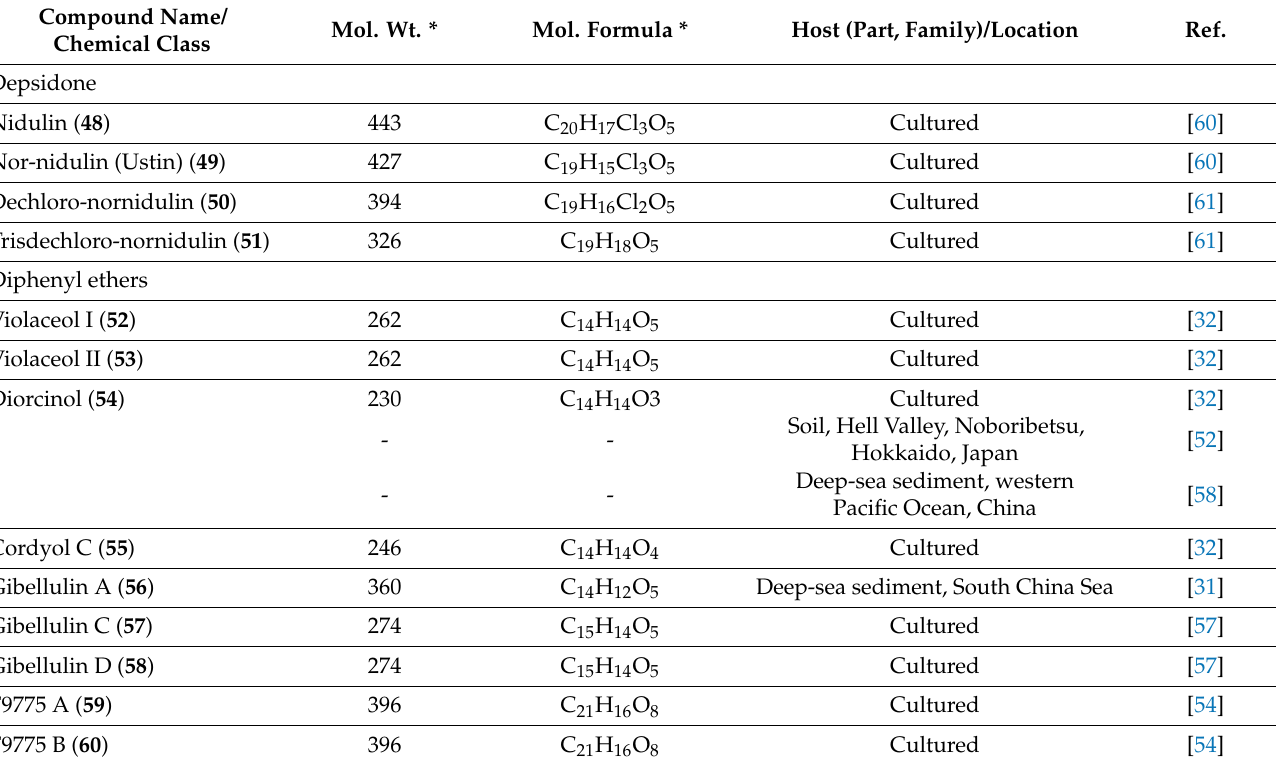
Table 4. Depsidone and diphenyl ethers reported from Aspergillus nidulans